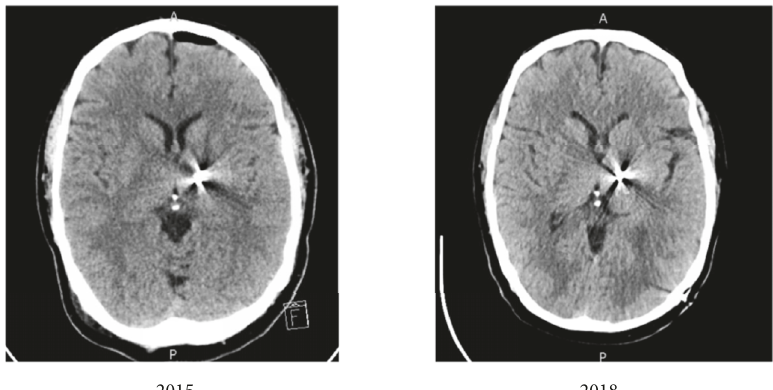
Figure 2: CT of head from 2015 and 2018 demonstrating no obvious movement of DBS device or pathology surrounding